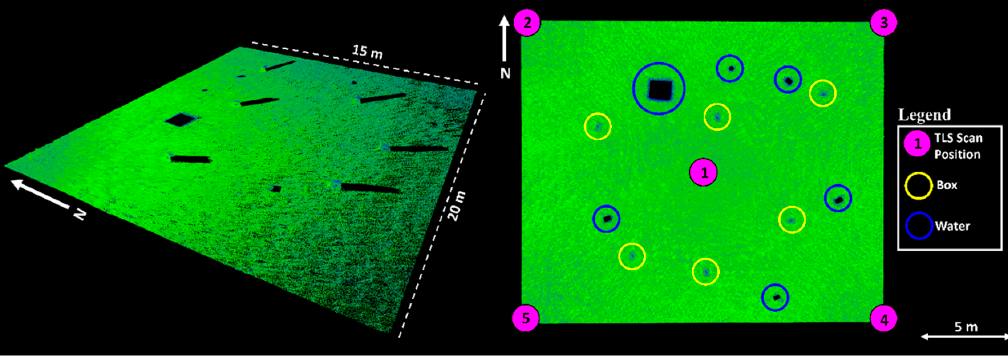
Figure 8. Overview of the test site (left) and layout map indicating scan locations and data gap sources (right). ISPRS Int. J. Geo-Inf. 2020 , 9 , x FOR PEER REVIEW